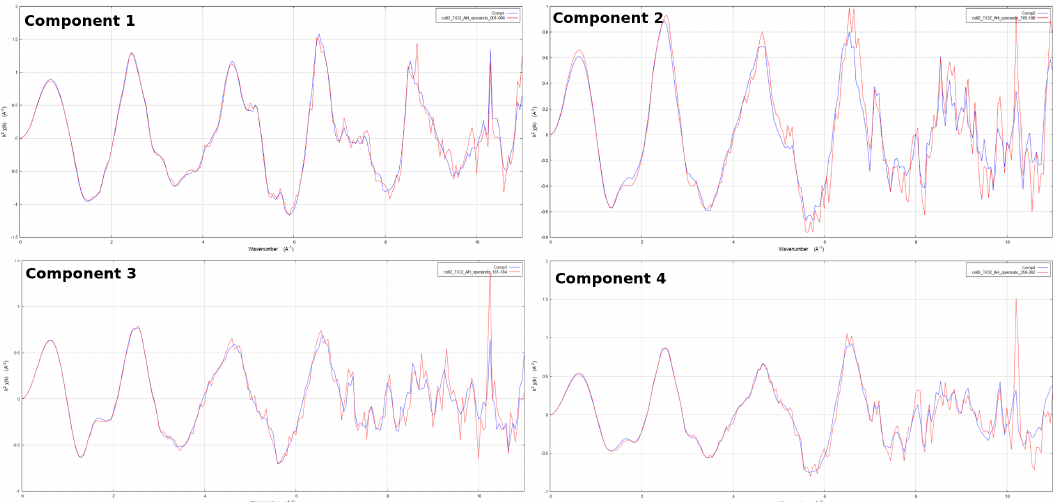
Figure A3. Comparison of EXAFS signal in k-space of MCR-ALS pure components (blue) and selected experimental spectra (red).The noise reduction for the MCR-ALS pure components compared to experimental spectra is